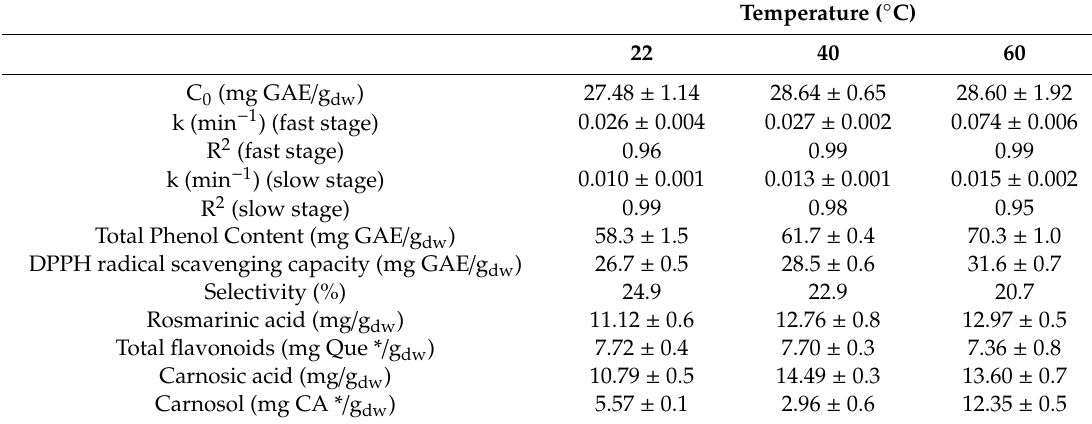
Table 2. The e ff ect of temperature on the initial concentration of phenolics in the solvent (C 0 ), the rate constant (k) of each extraction step, the total phenolic content (TPC), antiradical capacity, selectivity, rosmarinic acid, total flavonoids, carnosic acid, and carnosol, recovered after 70 min of extraction performed with acetone 40%, at a solid-to-liquid ratio 1:20 and non-specific particle size. The correlation coe ffi cients (R 2 ) of fitting Equation (1) to experimental data are also